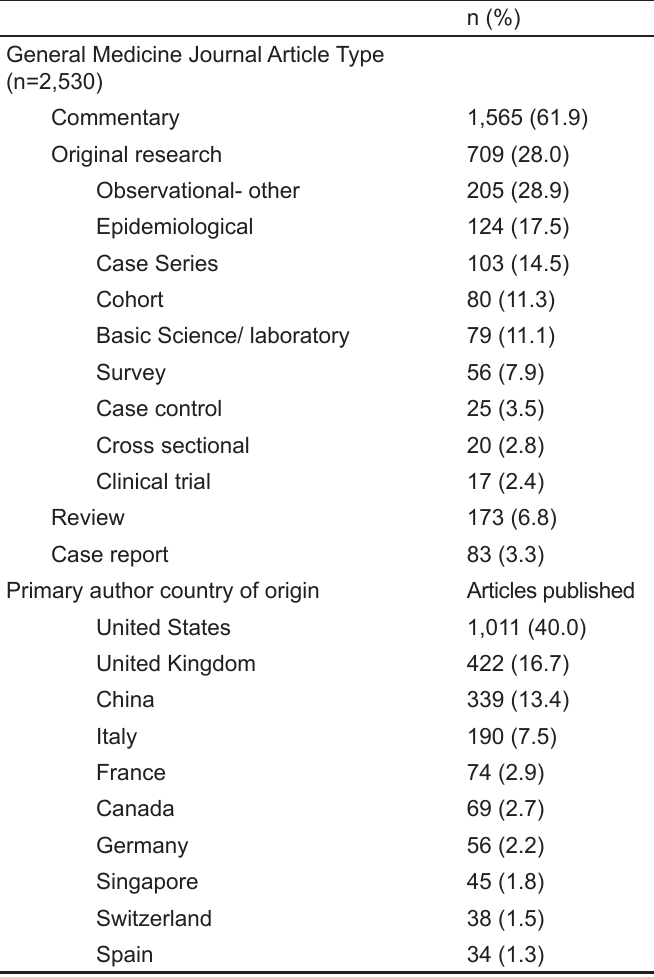
Table 1. Characteristics of the 125 top-ranked general